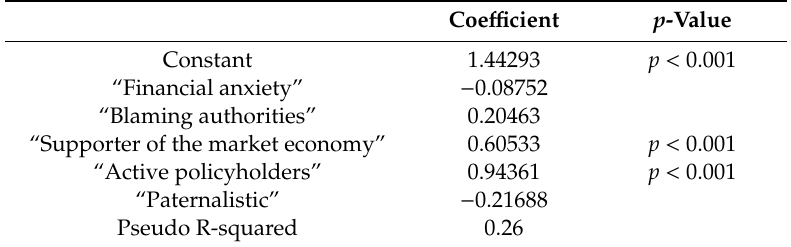
Table 5. Influence of the typology of the respondents on the choice of compulsory or voluntary insurance programs (N =